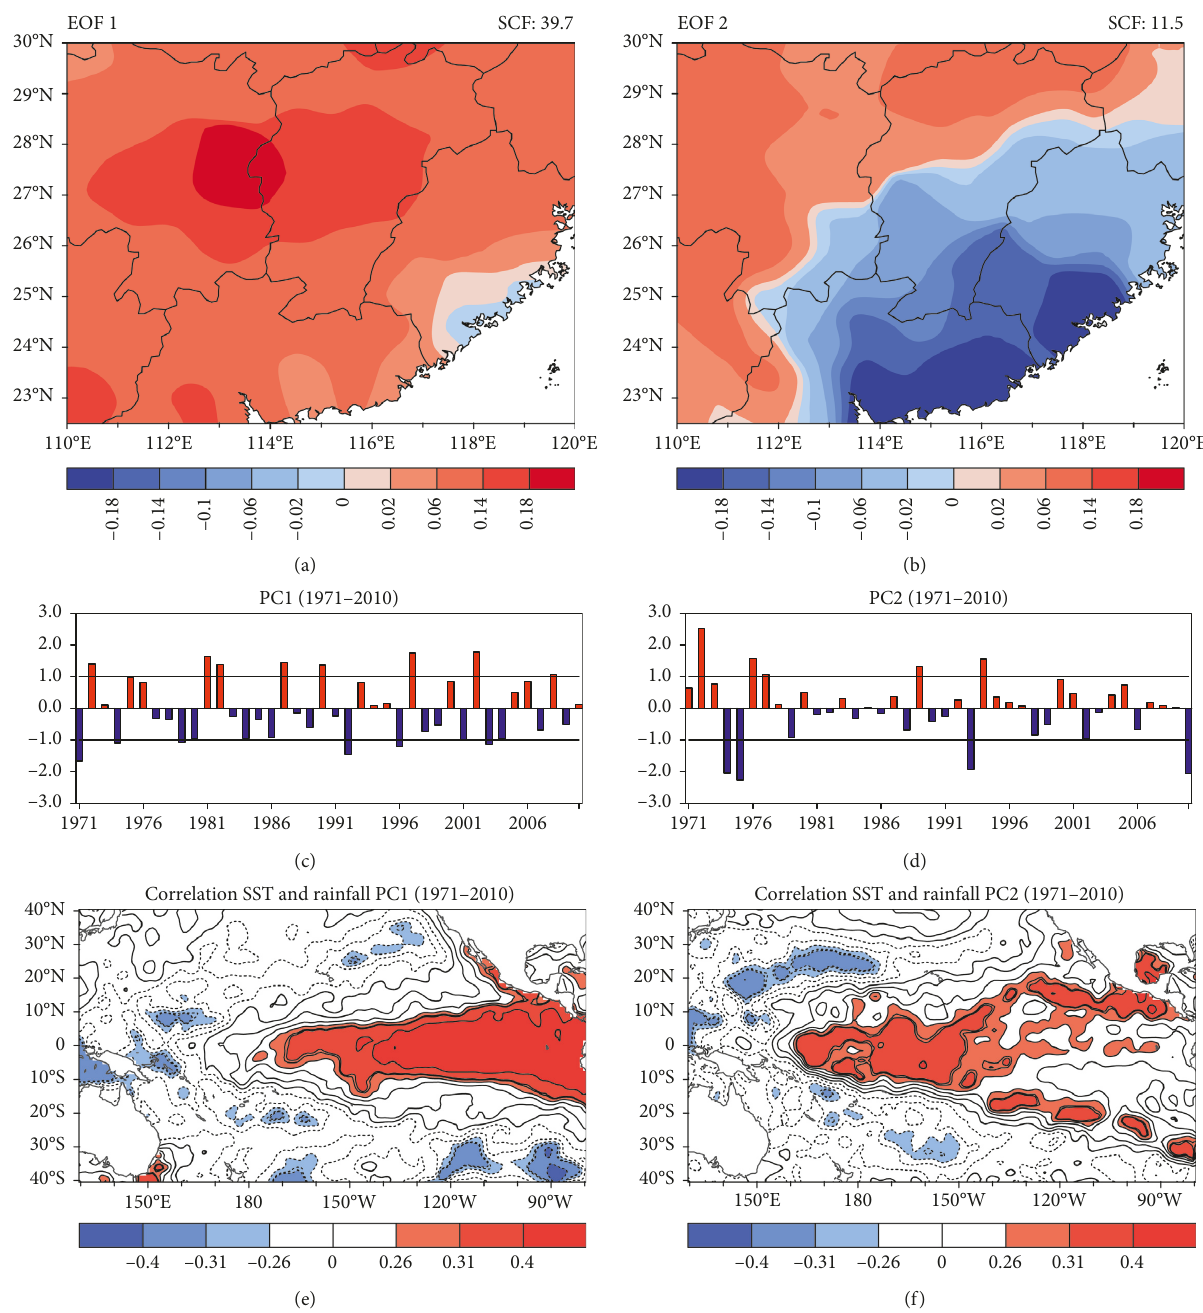
Figure 4: The EOF of rainfall after FFT high-pass filter (retain signal below 9 years): the first spatial mode (a) and corresponding temporal coefficient (c) and the second spatial mode (b) and corresponding temporal coefficient (d). (e, f) The correlation pattern between PC1, PC2, and autumn SSTand 0.26, 0.31, and 0.4 denote critical values of significance t -test at 90%, 95%, and 99% confidence level,